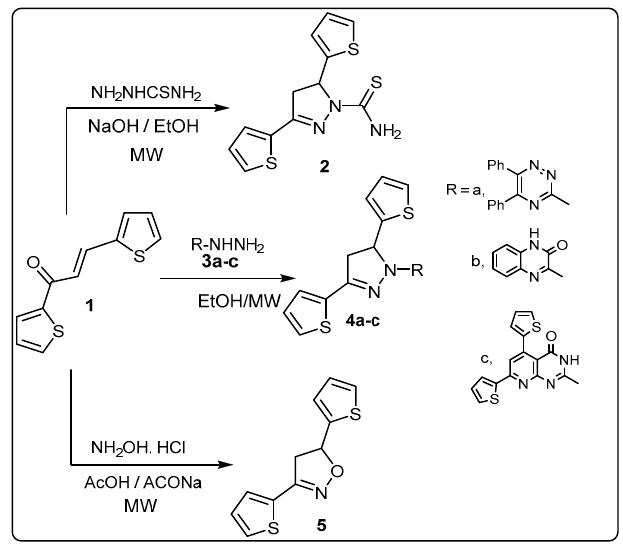
Table 1. Comparison between conventional heating and microwave irradiation for synthesis of compounds 4a – c , 8a – e , 11a , b , 13 , and 15 .